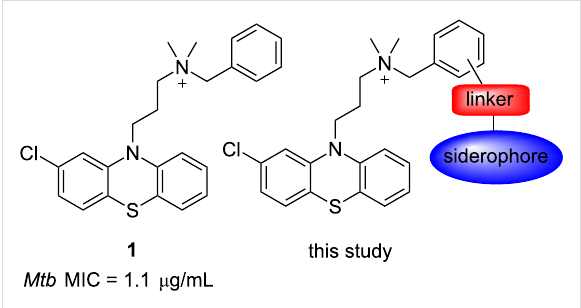
Figure 1: NDH-2 is a validated target for 1 with an MIC of 1.1 µg/mL against M. tuberculosis